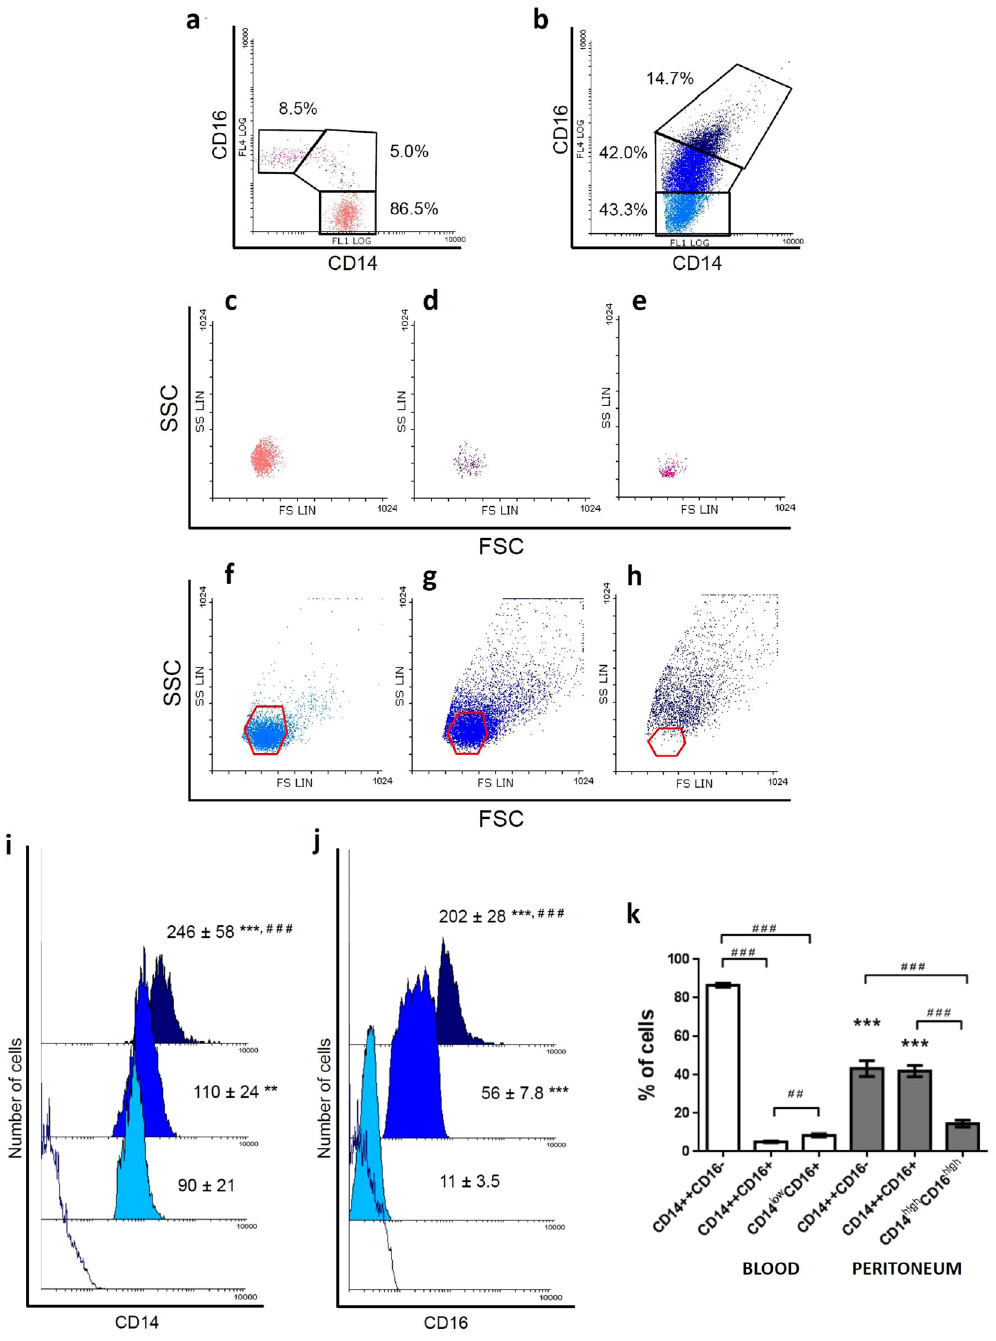
Figure 1. Flow Cytometry analysis of human peritoneal monocyte/macrophage subsets based on the CD14/ CD16 expression pattern and Forward/Side Scattering compared to blood. Representative FACS dot-plot of CD14 and CD16 expression pattern of blood monocytes and gates selecting the three different CD14/ CD16 subsets (CD14 ++ CD16 − , CD14 ++ CD16 + and CD14 + /low CD16 + ) is shown ( a ). Representative FACS dot-plot of CD14 and CD16 expression pattern of peritoneal monocytes/macrophages and gates selecting the three different CD14/CD16 subsets (CD14 ++ CD16 − , CD14 ++ CD16 + and CD14 high CD16 high ) are shown ( b ). Percentages refer to the mean of cell subpopulations gated on the total population of monocyte/macrophage cells. Comparison of the morphological distribution of blood monocytes ( c , d ) and peritoneal monocyte/ macrophage subsets ( f – h ) is also displayed as dot-plots. For comparative purposes, overlay red colour polygons indicate the limits of the morphological regions in which the corresponding blood monocytes are included: CD14 ++ CD16 − ( f ), CD14 ++ CD16 + ( g ) and CD14 + /low CD16 + ( h ). Representative FACS mean fluorescence intensity (MFI) histograms and mean MFI ± SEM of CD14 ( i ) and CD16 ( j ) expression within each peritoneal monocyte/macrophage subpopulation are displayed partially overlaid. Empty histogram shows the corresponding isotype controls, light blue histograms correspond to CD14 ++ CD16 − cells, bright blue to the CD14 ++ CD16 + subset, and dark blue to the CD14 high CD16 high subset. Mann-Whitney U test: ** p <